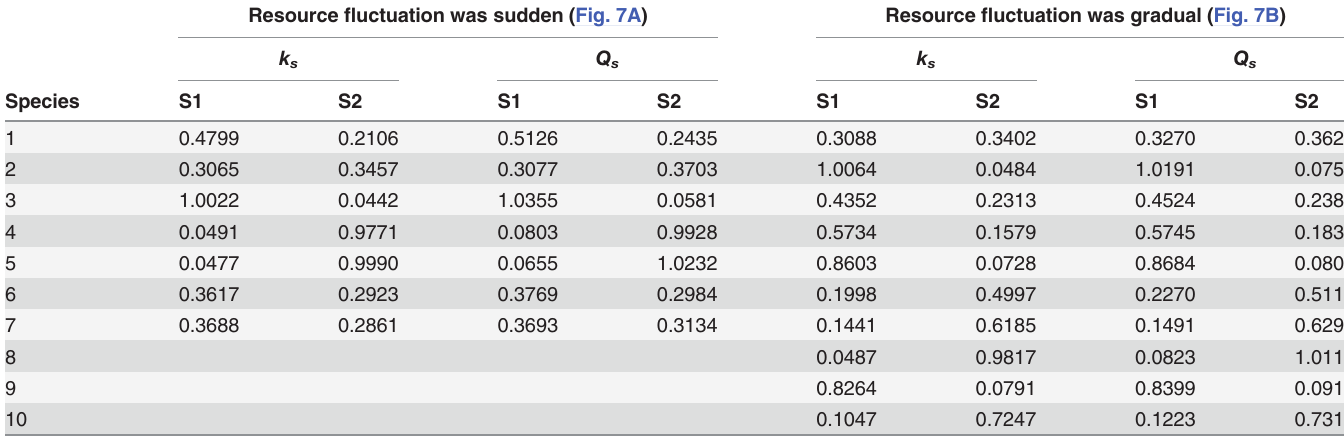
Table 3. Life history traits ( k s and Q s for resources S1 and S2) of species from representative simulations shown in Fig. 7. Resource fl uctuation was sudden (Fig.